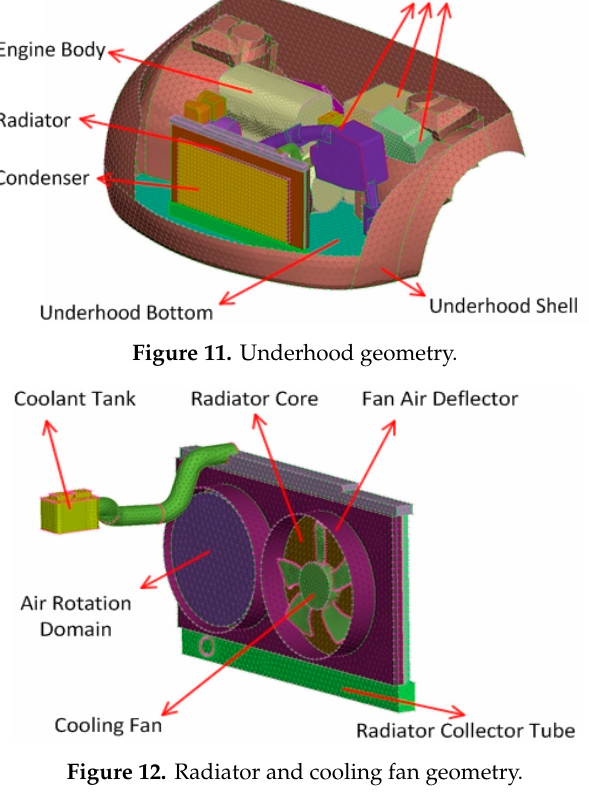
Figure 12. Radiator and cooling fan geometry.